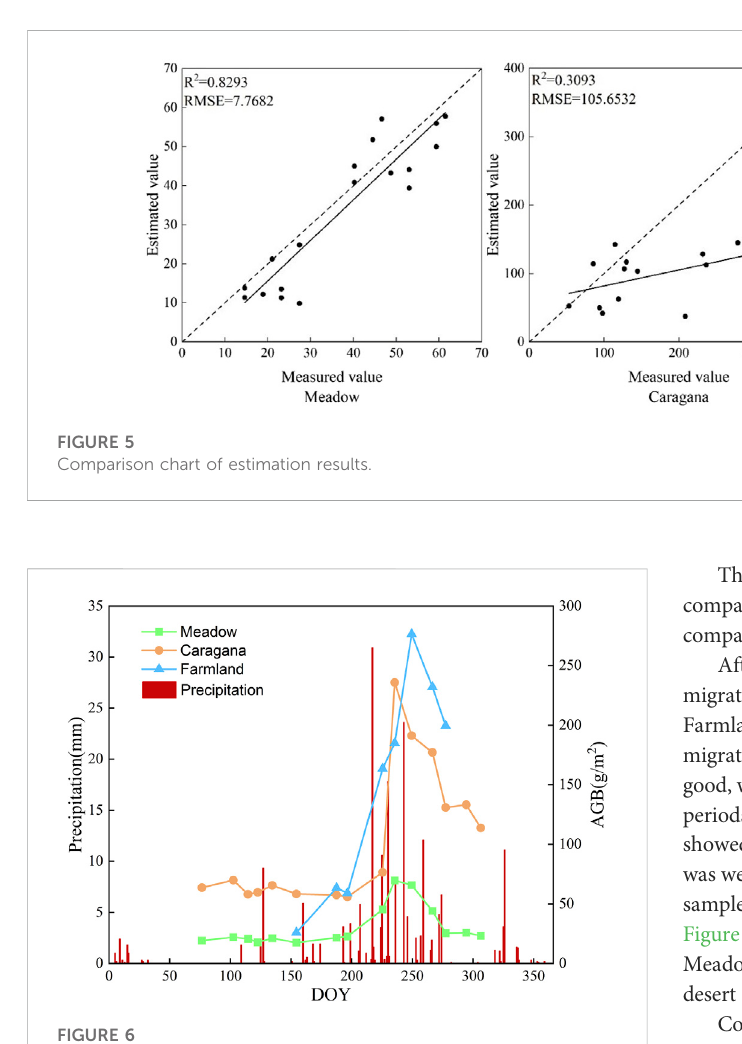
FIGURE 6 Monitoring results of biomass time series in Wanjigou Village in 2020 showing timing of precipitation and aboveground biomass (ABG) for meadow, Caragana, and